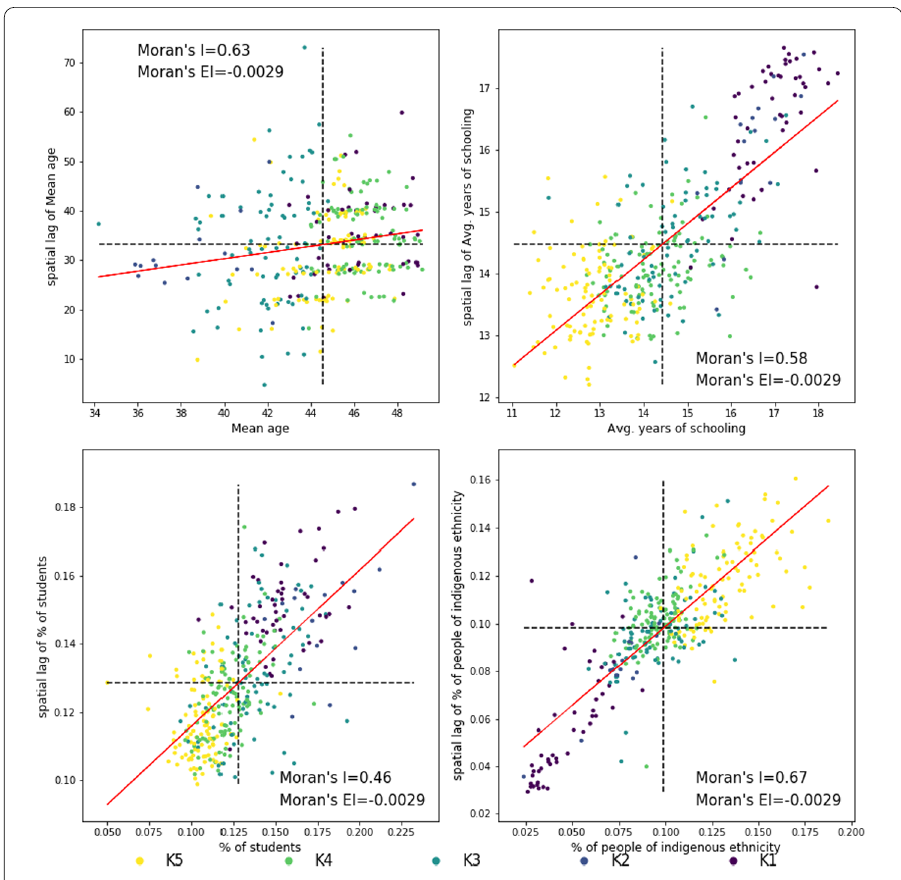
Figure 7 Moran scatterplot for the census features. It is clear how, for all the features but the mean age, the census segments (K1 and K5 in particular) are strongly segregated. We observe different patterns for the